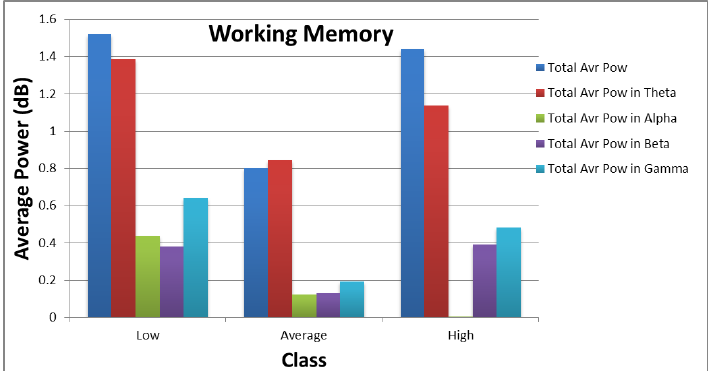
Figure 11. Distribution of average power values across different categories of working memory.